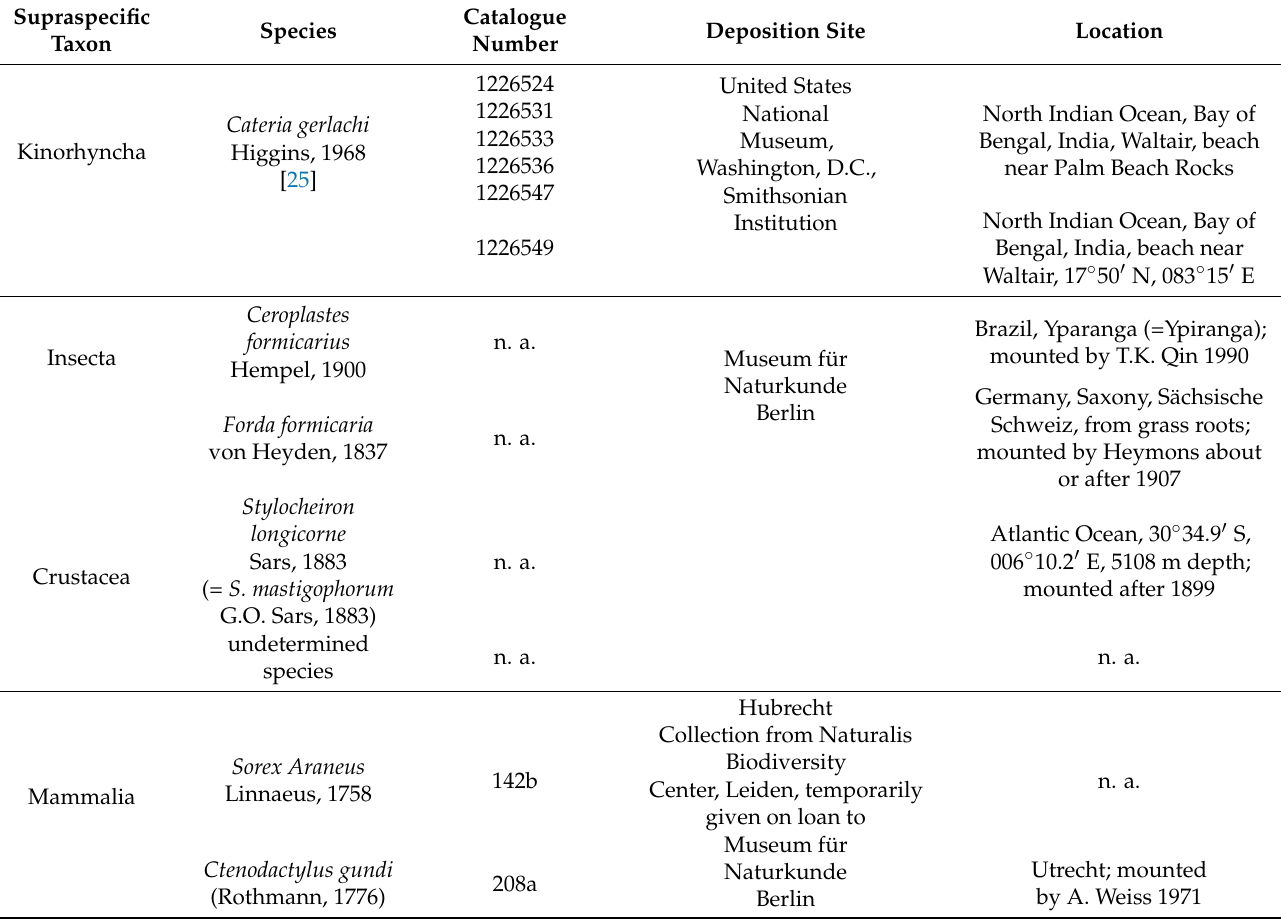
Table 1. Origin of specimens